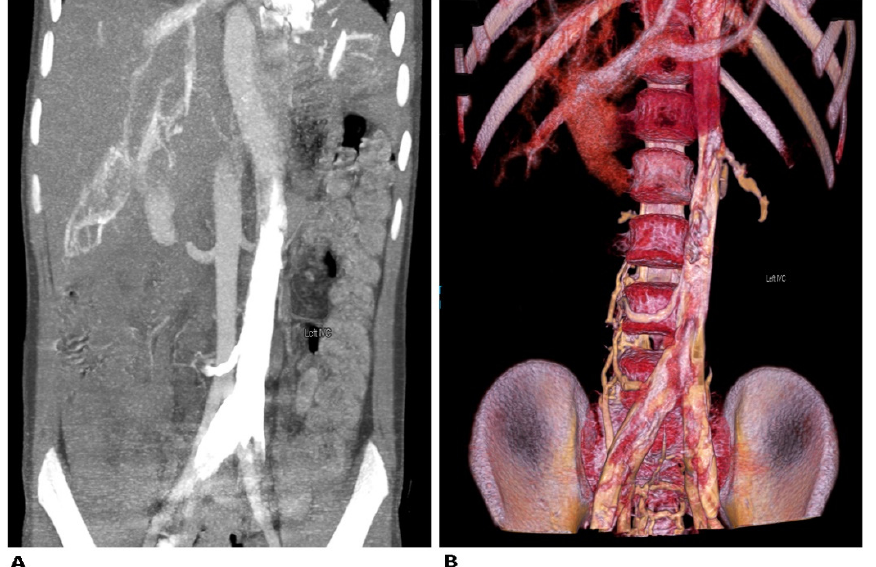
Figure 17. Left sided inferior vena cava (Type II). ( A )—abdominal CT in the coronal plane. The contrast-enhanced left vena cava is positioned on the left side. ( B )—3D volume-rendered reconstruction in coronal view.